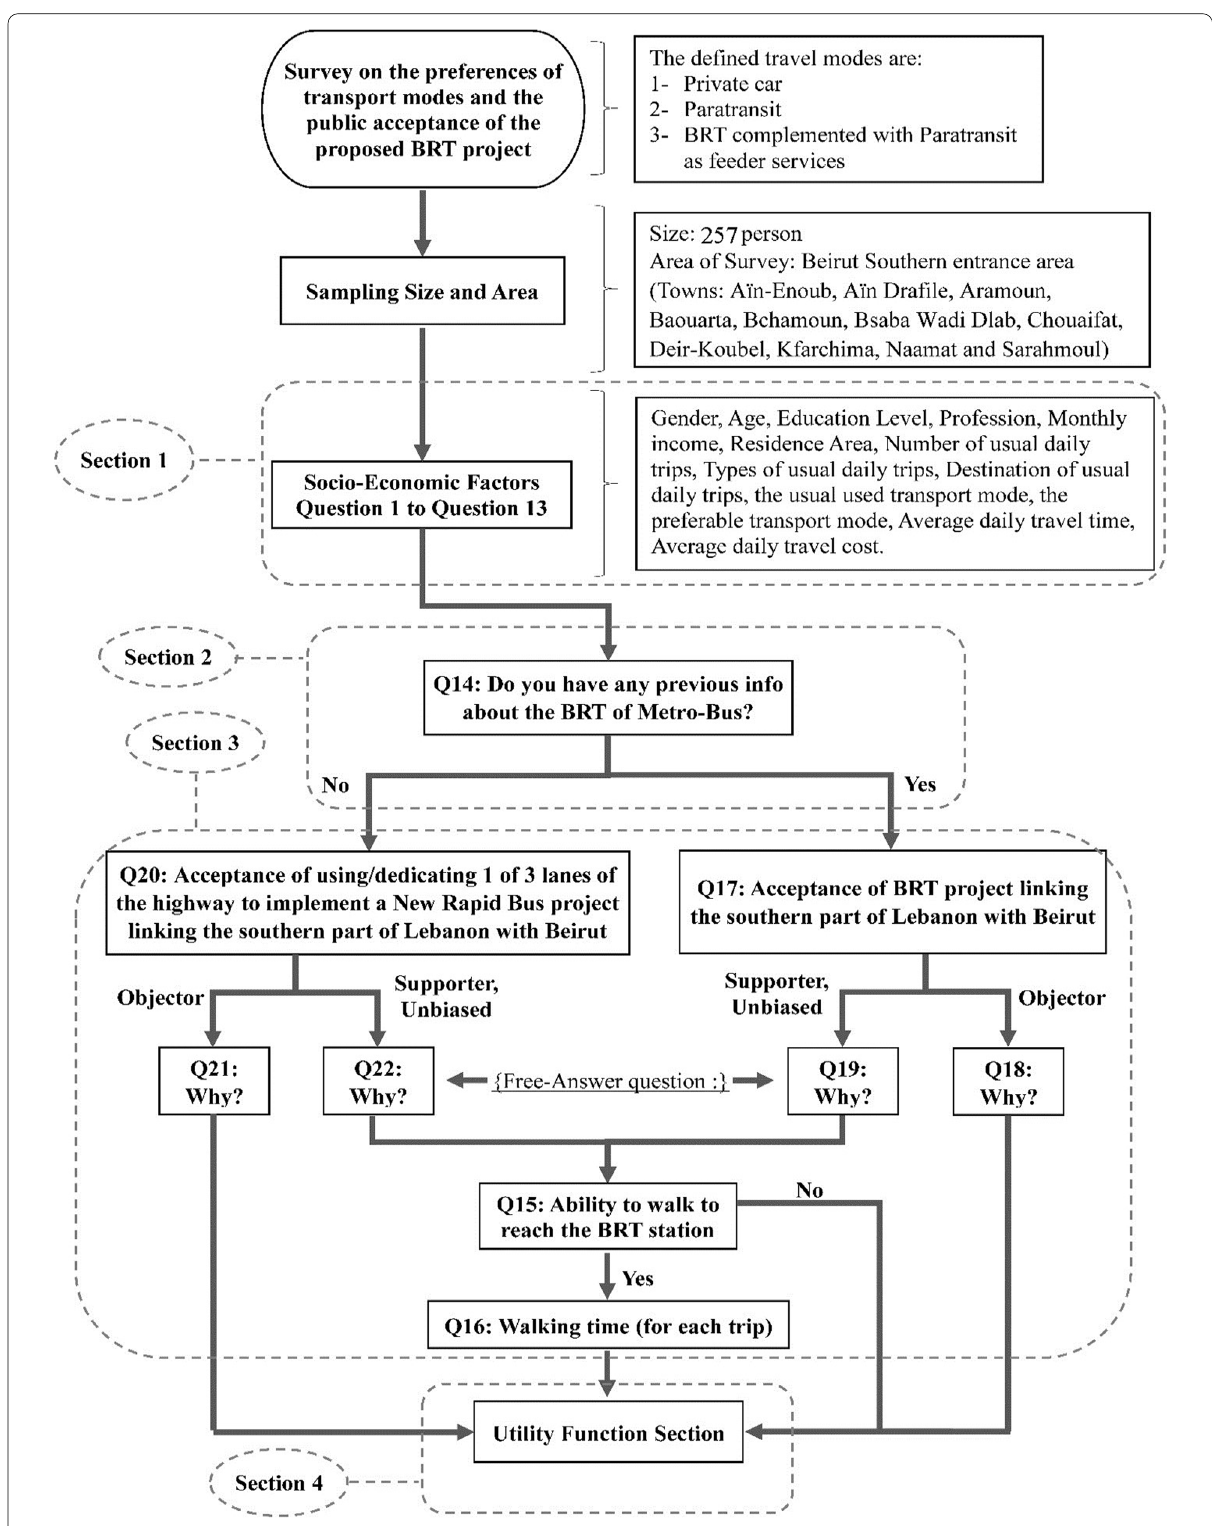
Fig. 3 Design methodology and sections of the adopted